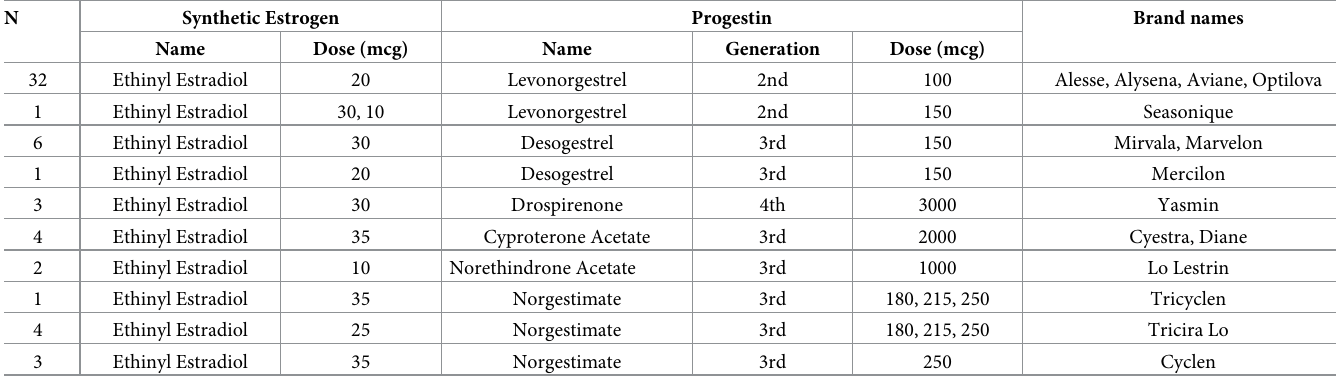
N-back Trial-by-trial lure 2-back accuracy. The full multilevel model for 2-back lure accuracy revealed met/met women were significantly more accurate than val/val women on lure trials ( β = -0.47, SE = 0.20, z = -2.39, p = .017). Additionally, it showed significant 3-way interactions between COMT , estrogen condition, and group ( val/val vs. met/met : β = .41, SE = .14, z = 2.94, p = .003; met/val vs. met/met : β = .38, SE = .13, z = 2.82, p = .005). Therefore, reduced models separating NOC from OC were run to understand gene-estrogen relations within each group. The reduced model with NOC revealed no significant differences between met/met and val/ val ( β = -.34, SE = .31, z = -1.10, p = .27), or met/met and met/val ( β = -.17, SE = .31, z = -.54, p = .59) on 2-back lure trial accuracy (Fig 3A). On the other hand, estrogen condition in NOC was a significant moderator of COMT on 2-back lure accuracy (Fig 3B), such that met/met Table 2. Oral contraceptive pill